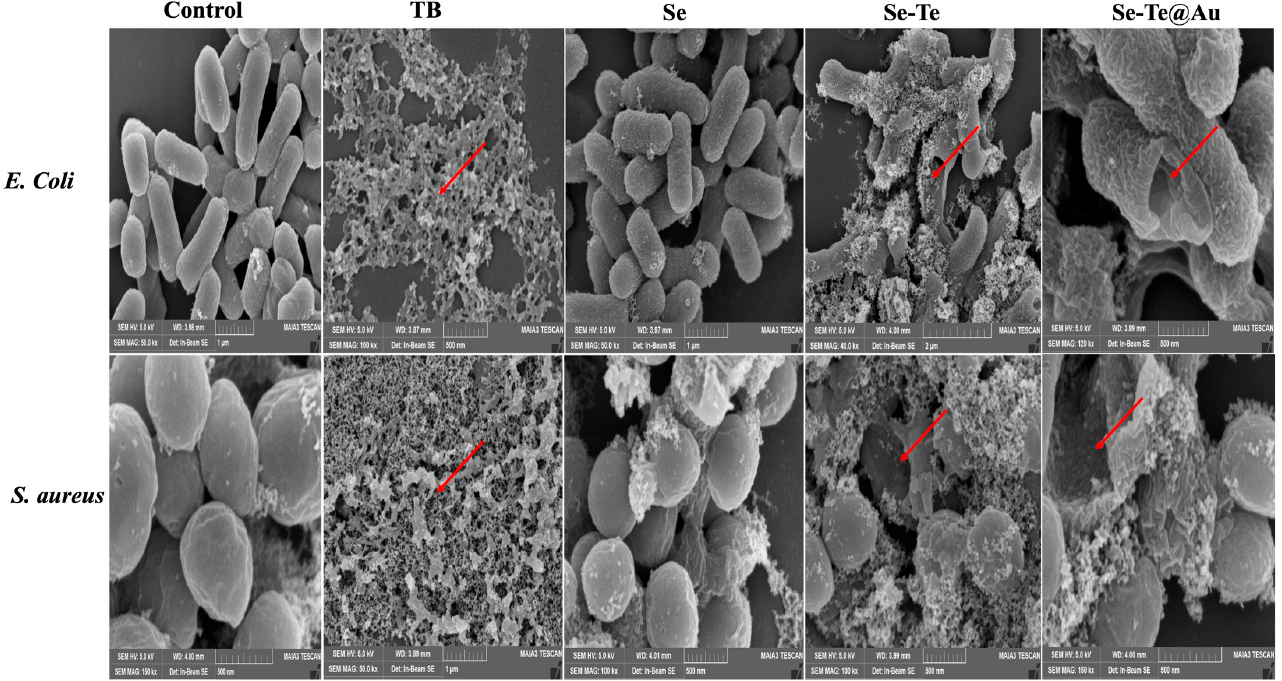
Figure 6. ( a ) Representative fluorescence images of E. coli cells after 2 h of treatment. The dead cells were visualized by PI staining (red), while DAPI (blue) helped to identify live cells. Scale bar is 25 µm. ( b ) Fluorescence images of S. aureus cells after 2 h of treatment. The dead cells were visualized by PI staining (red), while DAPI (blue) showed live cells.